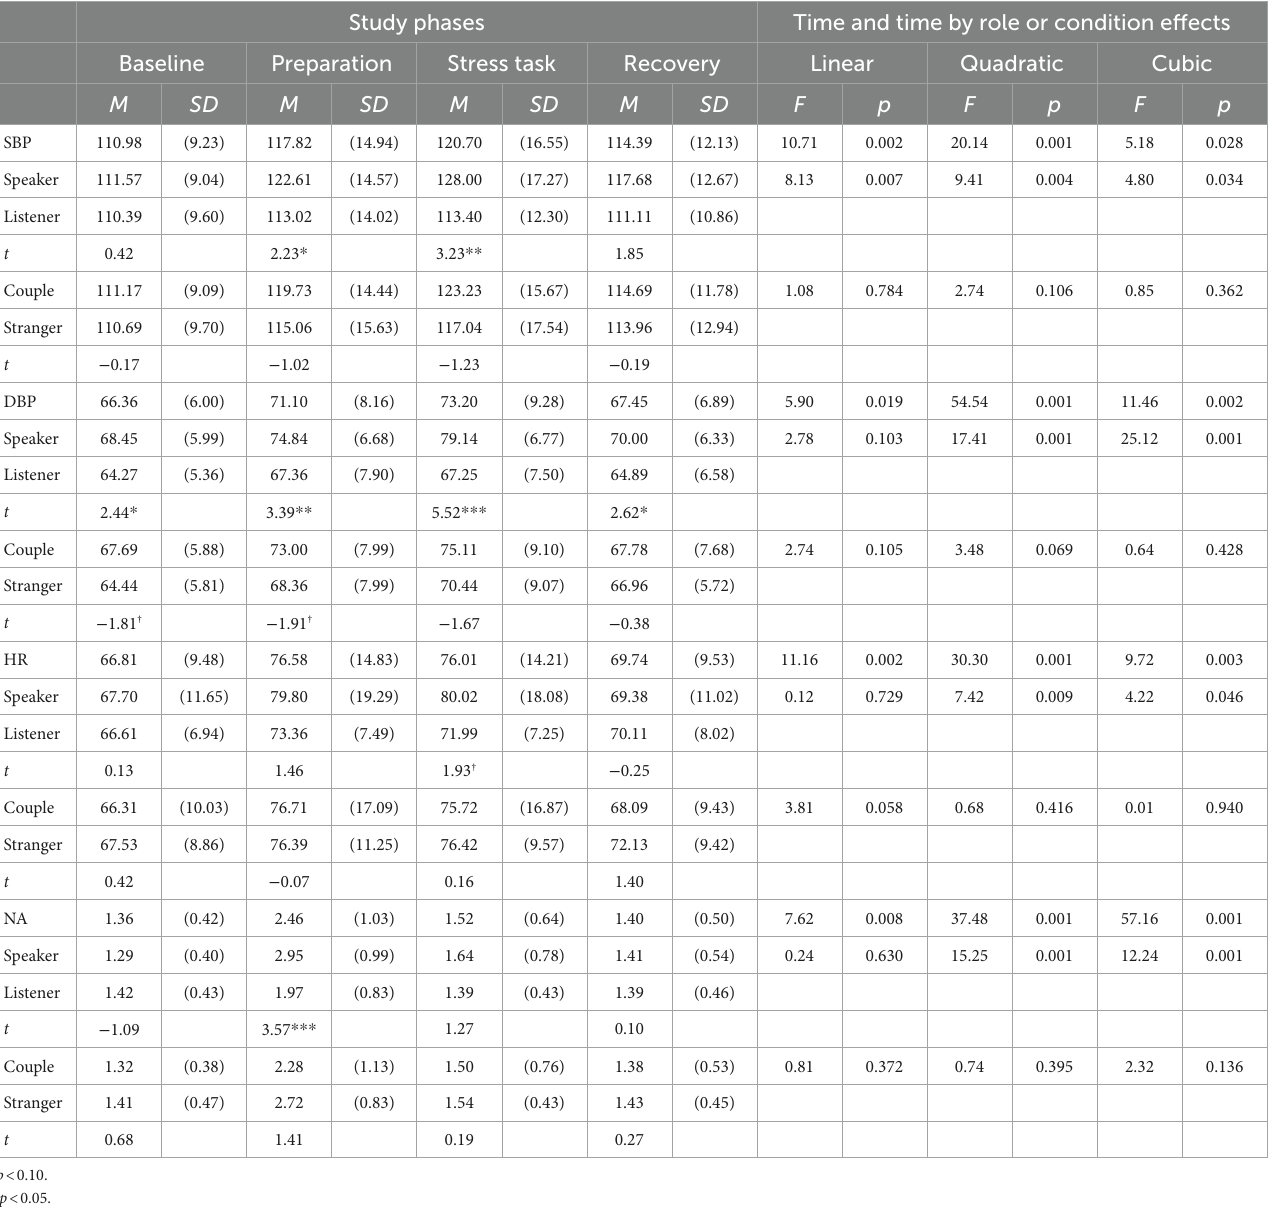
TABLE 2 Descriptives of cardiovascular activity indicators and negative affect by study phases, experimental role (speaker vs. listener), and experimental condition (paired with own partner: couple vs. with stranger); and t -test for each role or condition effects within a study